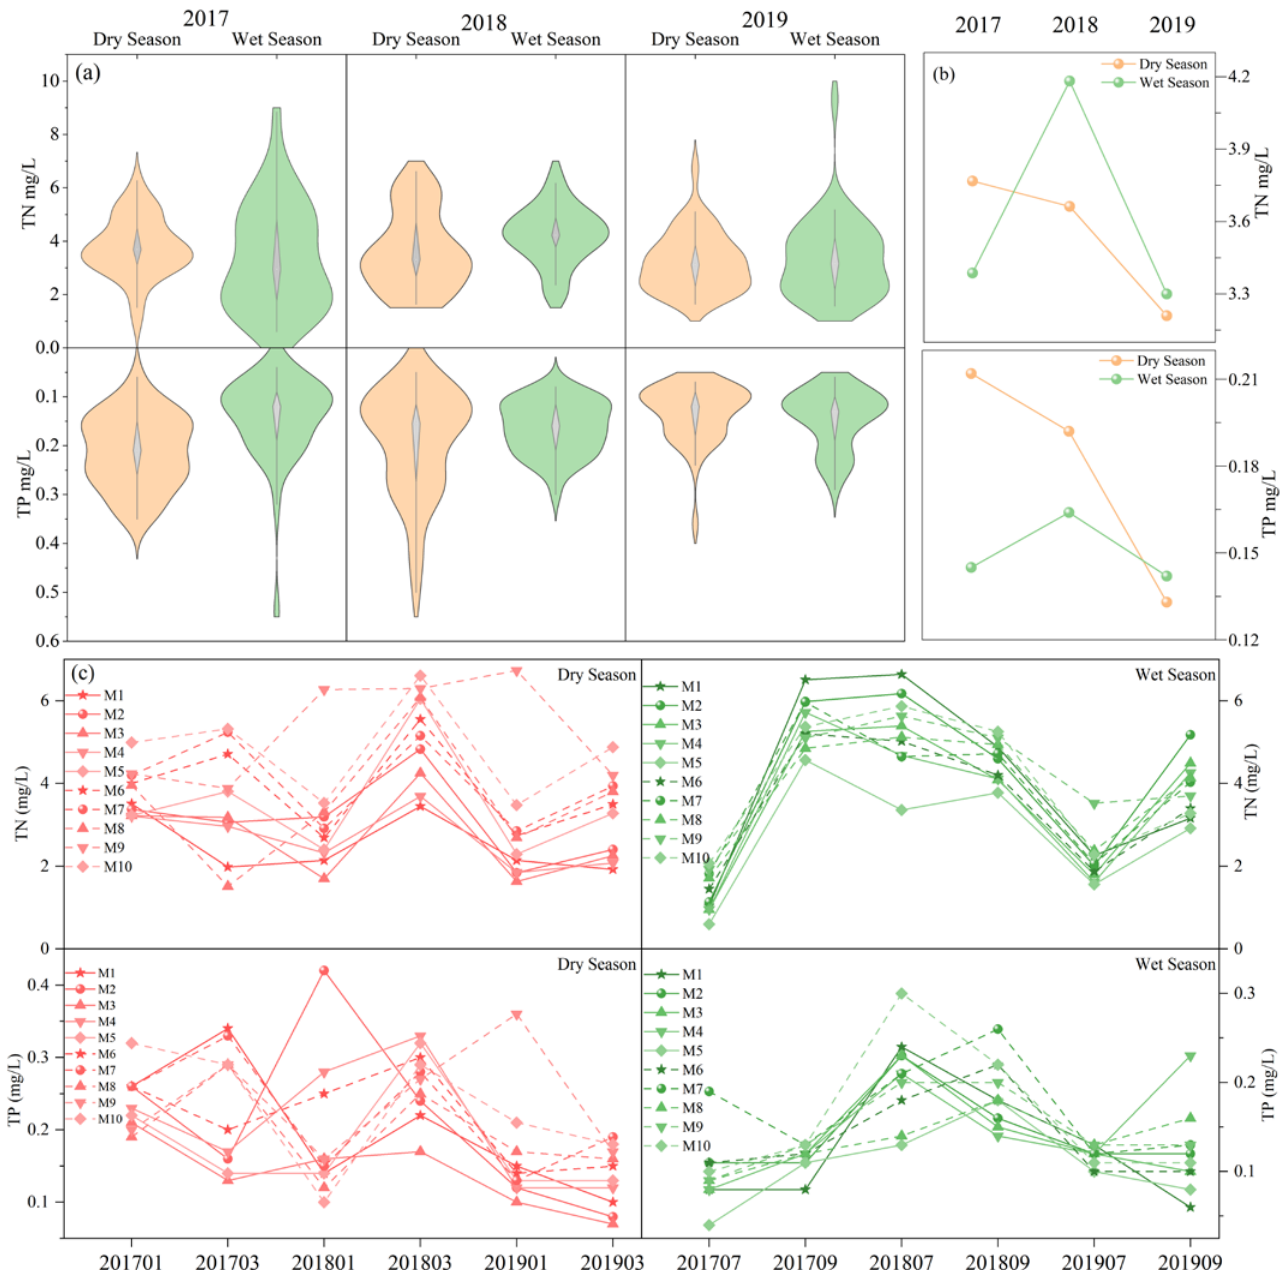
Figure 7. Characteristics of the temporal distribution of TN and TP concentrations. Distribution and and trend of all water-quality monitoring data ( a ), the annual variation in median water-quality trend of all water - quality monitoring data ( a ), the annual variation in median water - quality moni- monitoring data ( b ), temporal variation in each monitoring section ( c toring data ( b ), temporal variation in each monitoring section ( c ).